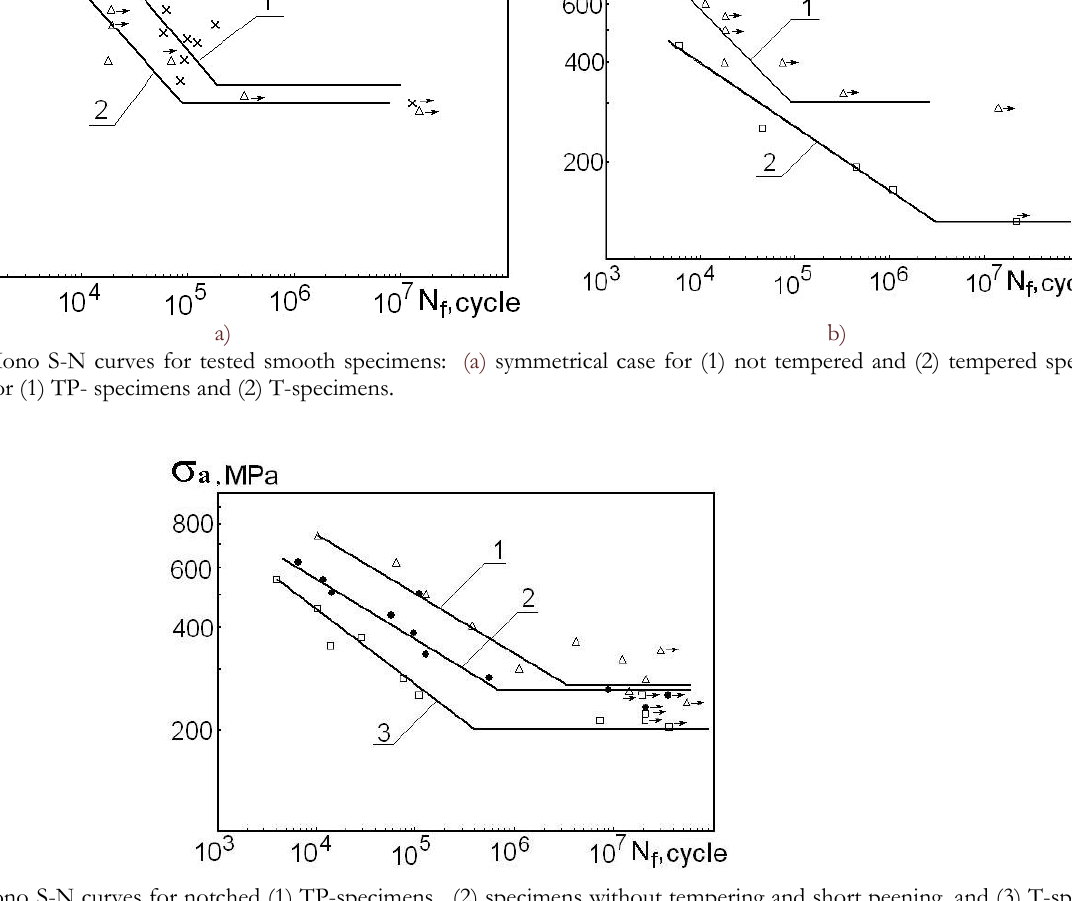
Figure 3: Mono S-N curves for notched (1) TP-specimens, (2) specimens without tempering and short peening, and (3) T-specimens tested under